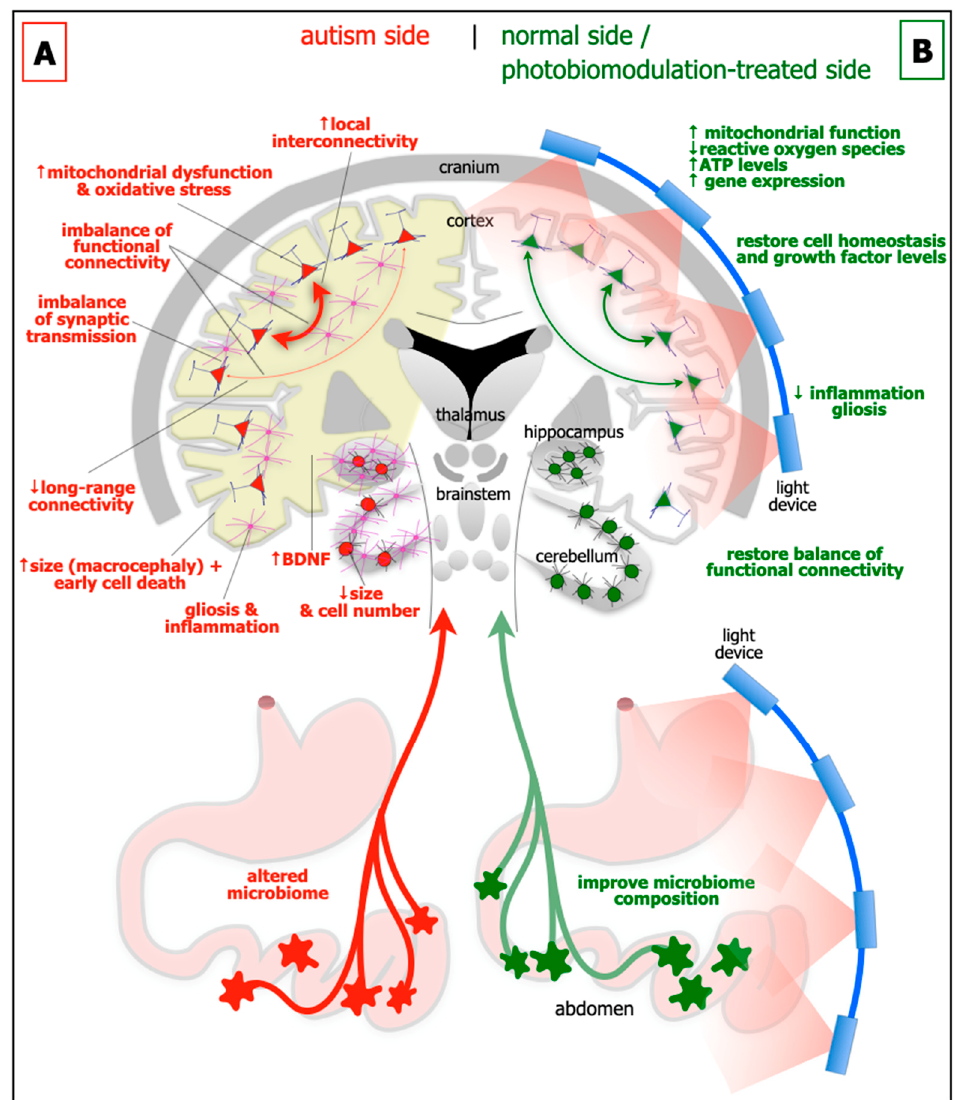
Figure 1. Schematic diagrams of the major abnormalities evident in autism ( A ; left side) as compared to normal, and after photobiomodulation treatment ( B ; right side). Autism is characterised by an altered microbiome in the gastrointestinal system (red star-like shapes), decrease in size of cerebellum and cerebellar cell number, increase in brain-derived neurotrophic factor (BDNF) levels in brain (yellow shade) and blood plasma, gliosis and inflammation in brain (pink cells), macrocephaly (increase in size of cortex), decrease in activity of long-range connectivity in cortex (thin red arrows), synaptic imbalance in brain, imbalance of functional connectivity, dysfunction and oxidative stress in brain (red cells) and increase in local interconnectivity in cortex (thick red arrows). We hypothesise that many if not all of these abnormalities will improve after photobiomodulation treatment to the head and to the abdomen (green cells and arrows). In particular, photobiomodulation will prompt; an increase in mitochondrial function, adenosine triphosphate (ATP) levels and gene expression, a reduction of oxidative stress, inflammation and gliosis, a restoration of cell homeostasis and growth factor levels, together with a restoration of a balanced functional activity across the brain.